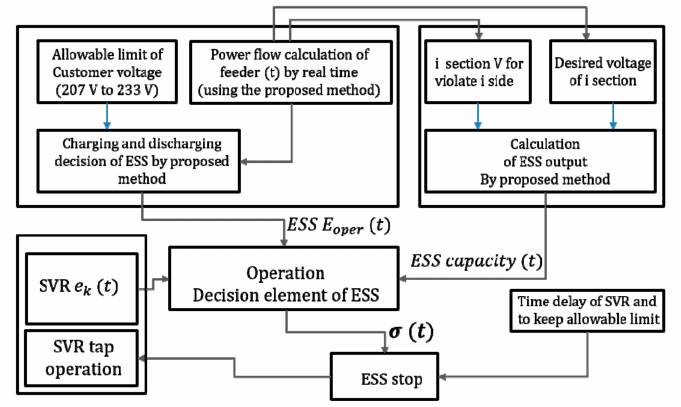
Figure 11. Operation block diagram of